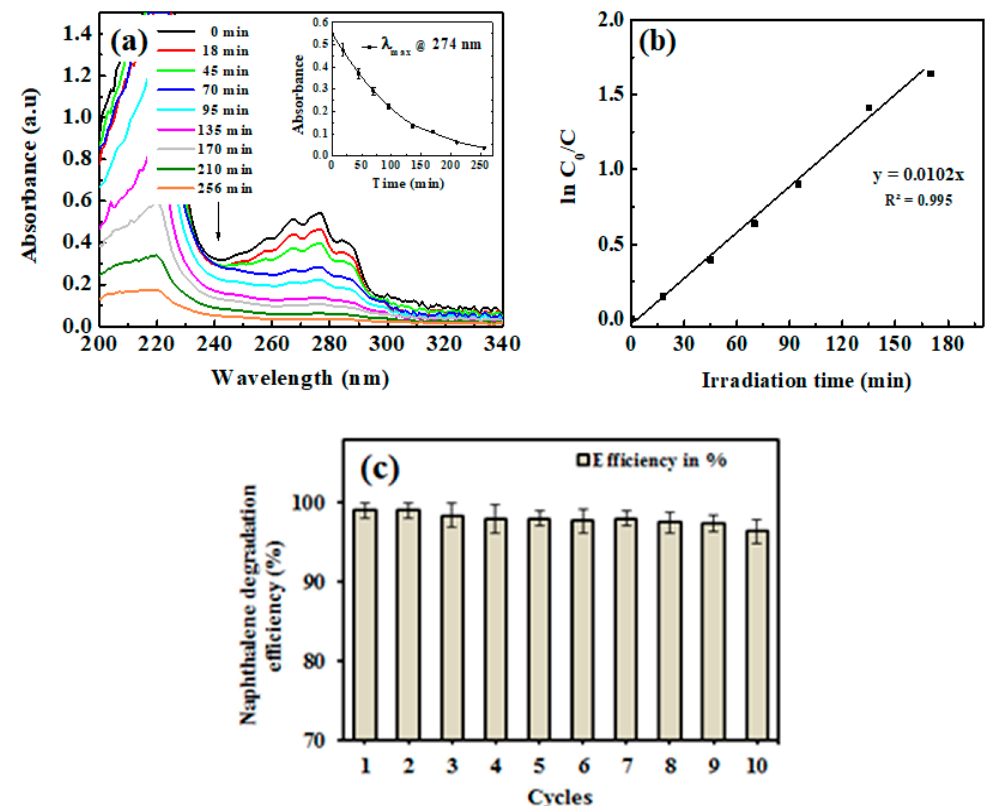
Figure 4. ( a ) UV-visible spectrum of naphthalene during degradation by ZnSk composite, with a plot of kinetic of absorbance change at 274 nm (inset), ( b ) first-order kinetic model fit to the degradation data. ( c ) Reusability of ZnSk composites for naphthalene degradation (80 mg ZnSk exposed to 43 mg/L naphthalene), and error bars represent standard deviation for three measurements.